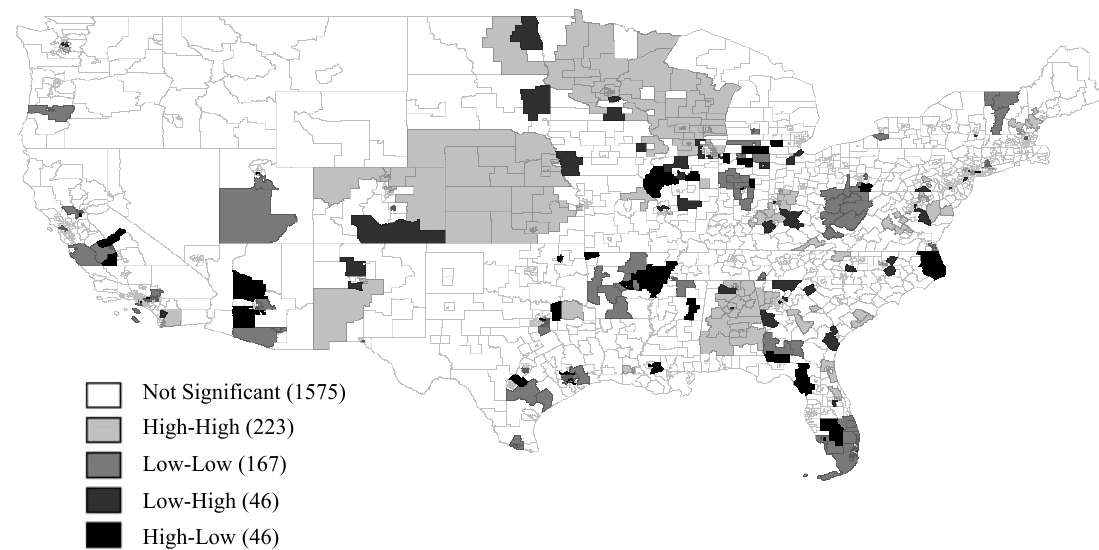
Figure 2. LISA cluster map.